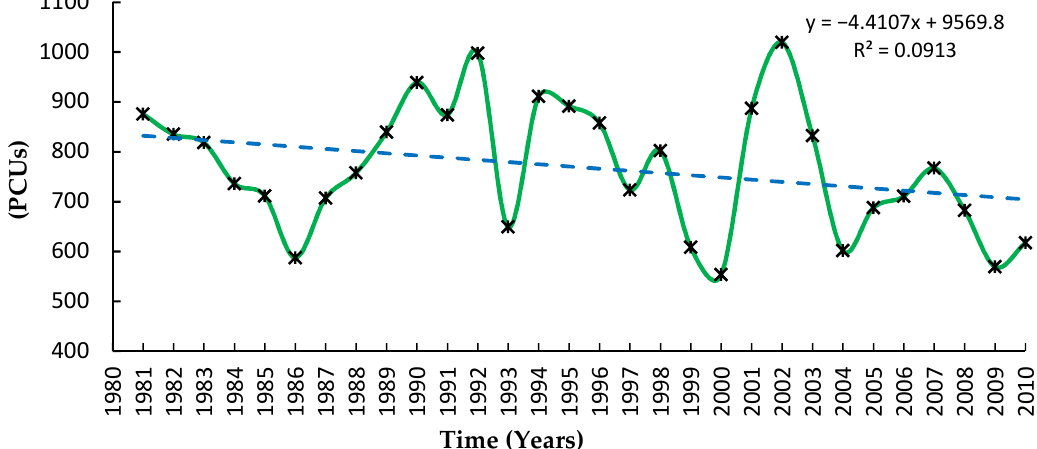
Figure 3. Observed accumulated positive chill units for Ceres for the period 1981–2010.